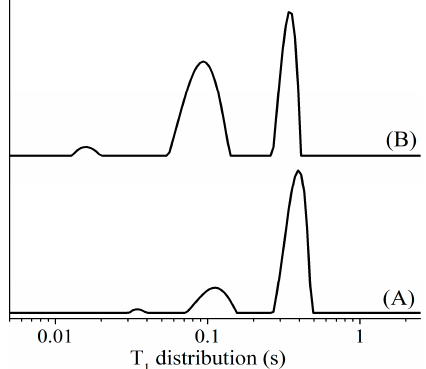
Figure 12. T 1 distribution time of obtained by the inverse Laplace transform of a CWFP-T 1 signal acquisition of beef samples with different fat contents: ( A ) 20% and ( B ) 62%. Adapted from Publication [39] , Copyright (2014), with permission from Wiley.